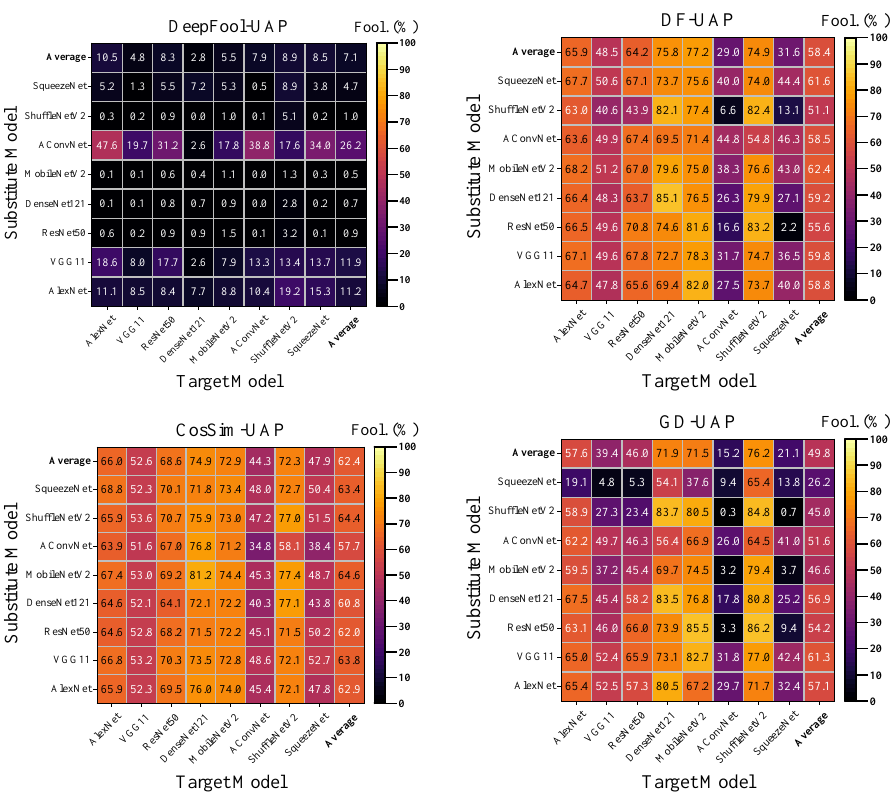
Figure 4. Transferability of UAPs generated by the studied attack algorithms. The fooling ratio is eval- uated by using the UAPs generated by substitute SARSIM models to attack the target MSTAR models.